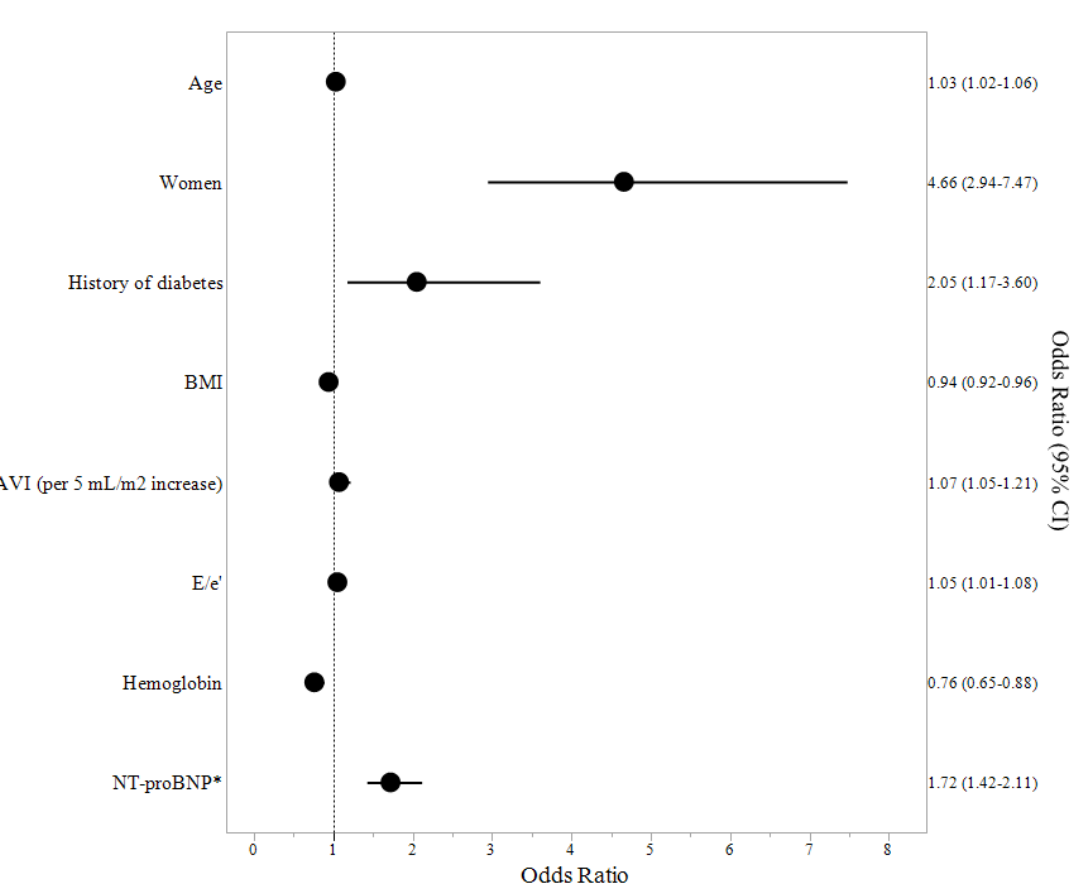
Figure 2. Multivariate predictors of VO 2 peak in HOCM patients. Significant independent predictors of the lowest VO 2 peak were age, female sex, a history of diabetes, BMI, left atrial volume index (LAVI, per 5 mL/m 2 increase), E/e’, hemoglobin, and NT-proBNP. * per SD increase. Odds ratio and 95% confidence interval are shown for each variable.